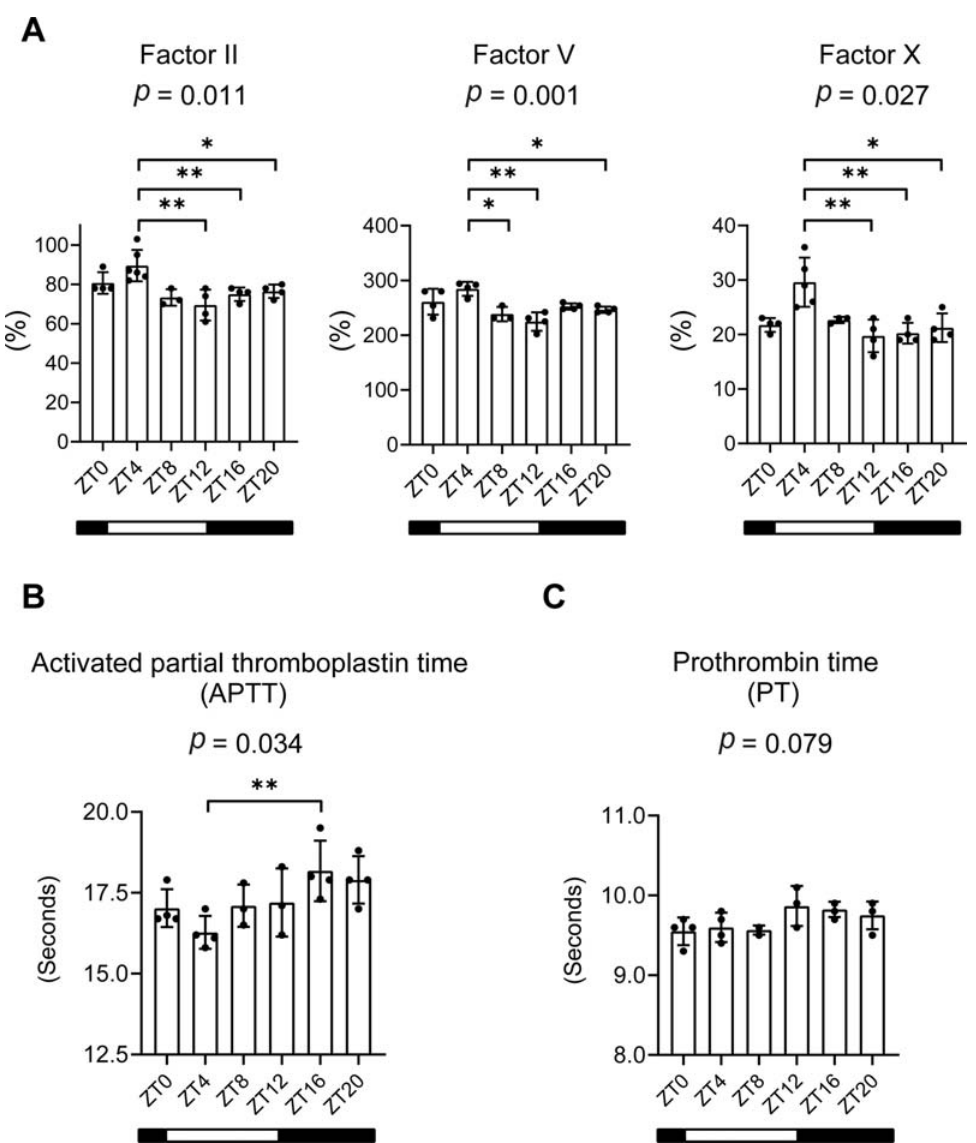
Fig. 1 Diurnal variations in coagulation factor activities in rats. Blood samples were obtained at zeitgeber times (ZT) 0, 4, 8, 12, 16, and 20. ( A ) The plasma activities of factors II, V, and X. ( B ) Activated partial thromboplastin time. ( C ) Prothrombin time. White and black horizontal bars indicate the light and dark periods, respectively. Data represent the means (cid:3) standard deviation ( n ¼ 3 – 6). The p -value (analysis of variance) is presented at the top of each panel. (cid:4) p < 0.05, (cid:4)(cid:4) p < 0.01 versus ZT4. TH Open Vol. 5 No. 2/2021 © 2021. The